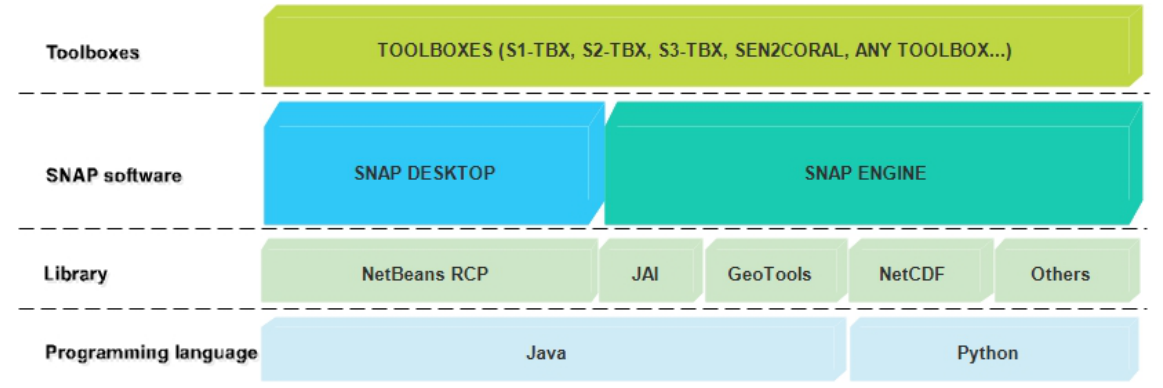
Figure 4. General architecture of SNAP software